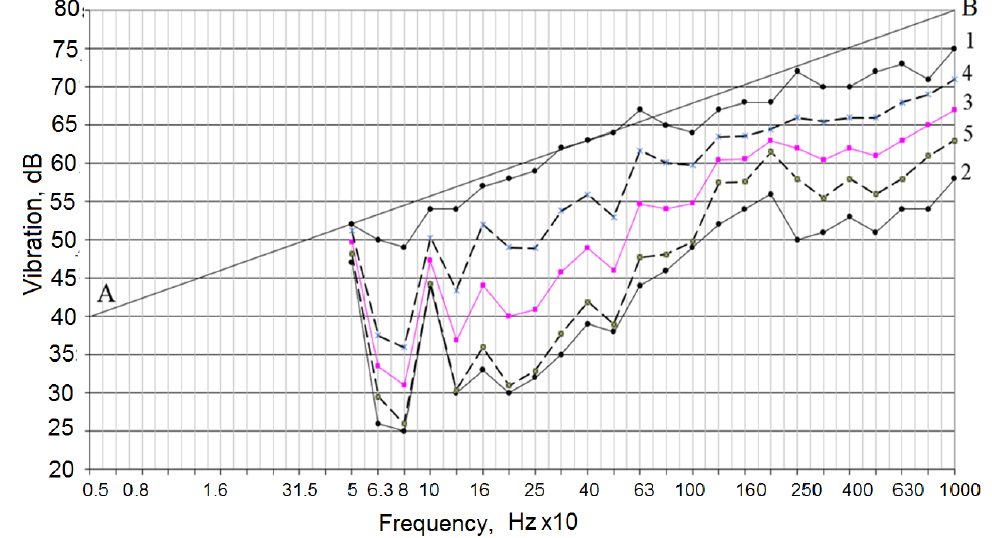
Figure 3. ЕM АNU 92-2 vibrations spectrogram: 1, 2 – maximum and minimum values of the levels; 3 – average values of the levels; 4, 5 – mean square deviation of the levels